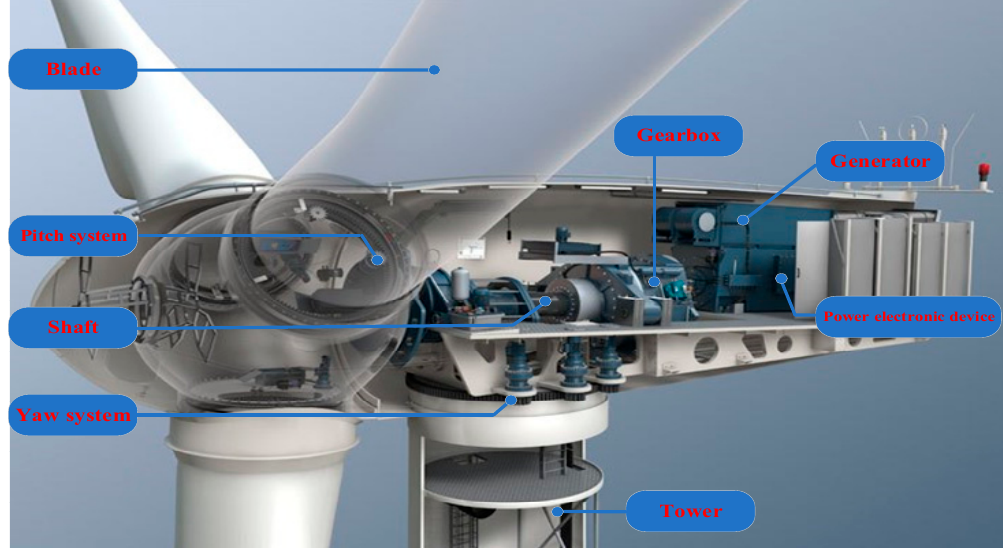
Figure 3. Doubly fed induction generator